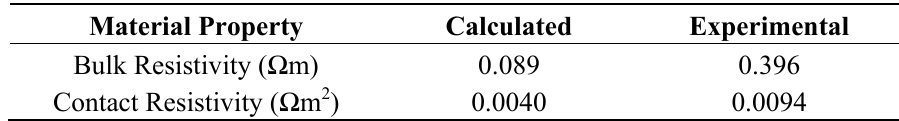
Table 2. Comparison of experimentally determined 15/30 CB composite resistivities to estimates calculated from homogeneous test